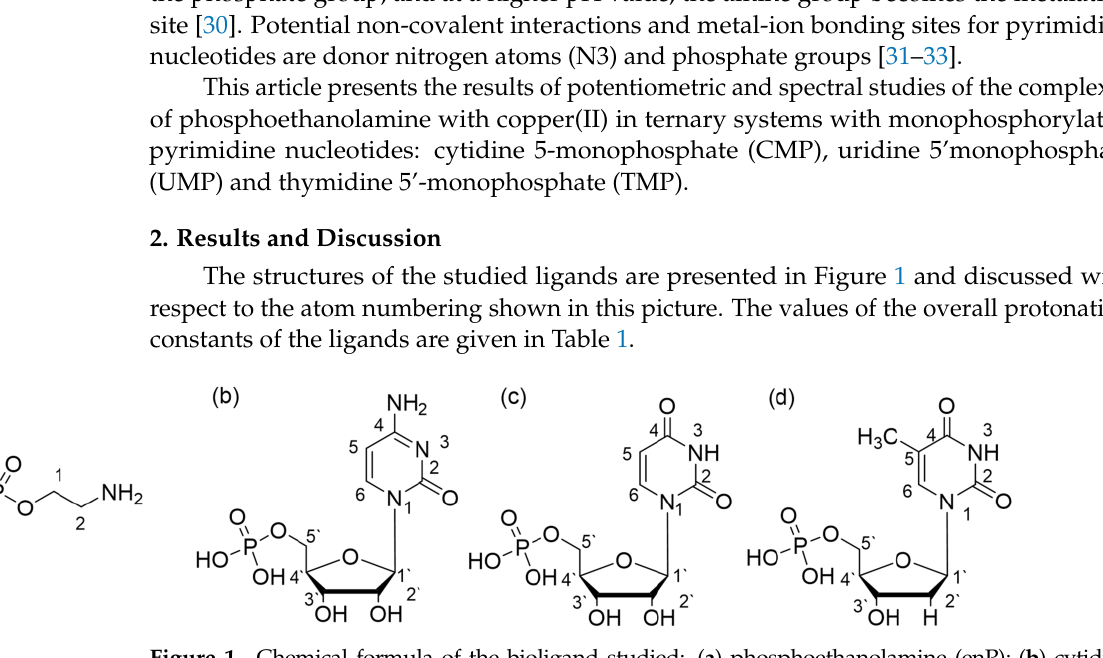
Figure 1. Chemical formula of the bioligand studied: ( a ) phosphoethanolamine (enP); ( b ) cytidine 5’-monophosphate (CMP); ( c ) uridine 5’-monophosphate (UMP); ( d ) thymidine 5’-monophosphate (TMP). Table 1. Protonation constants of ligands and stability constants for complexes in Cu(II)/L systems. Species enP [30]